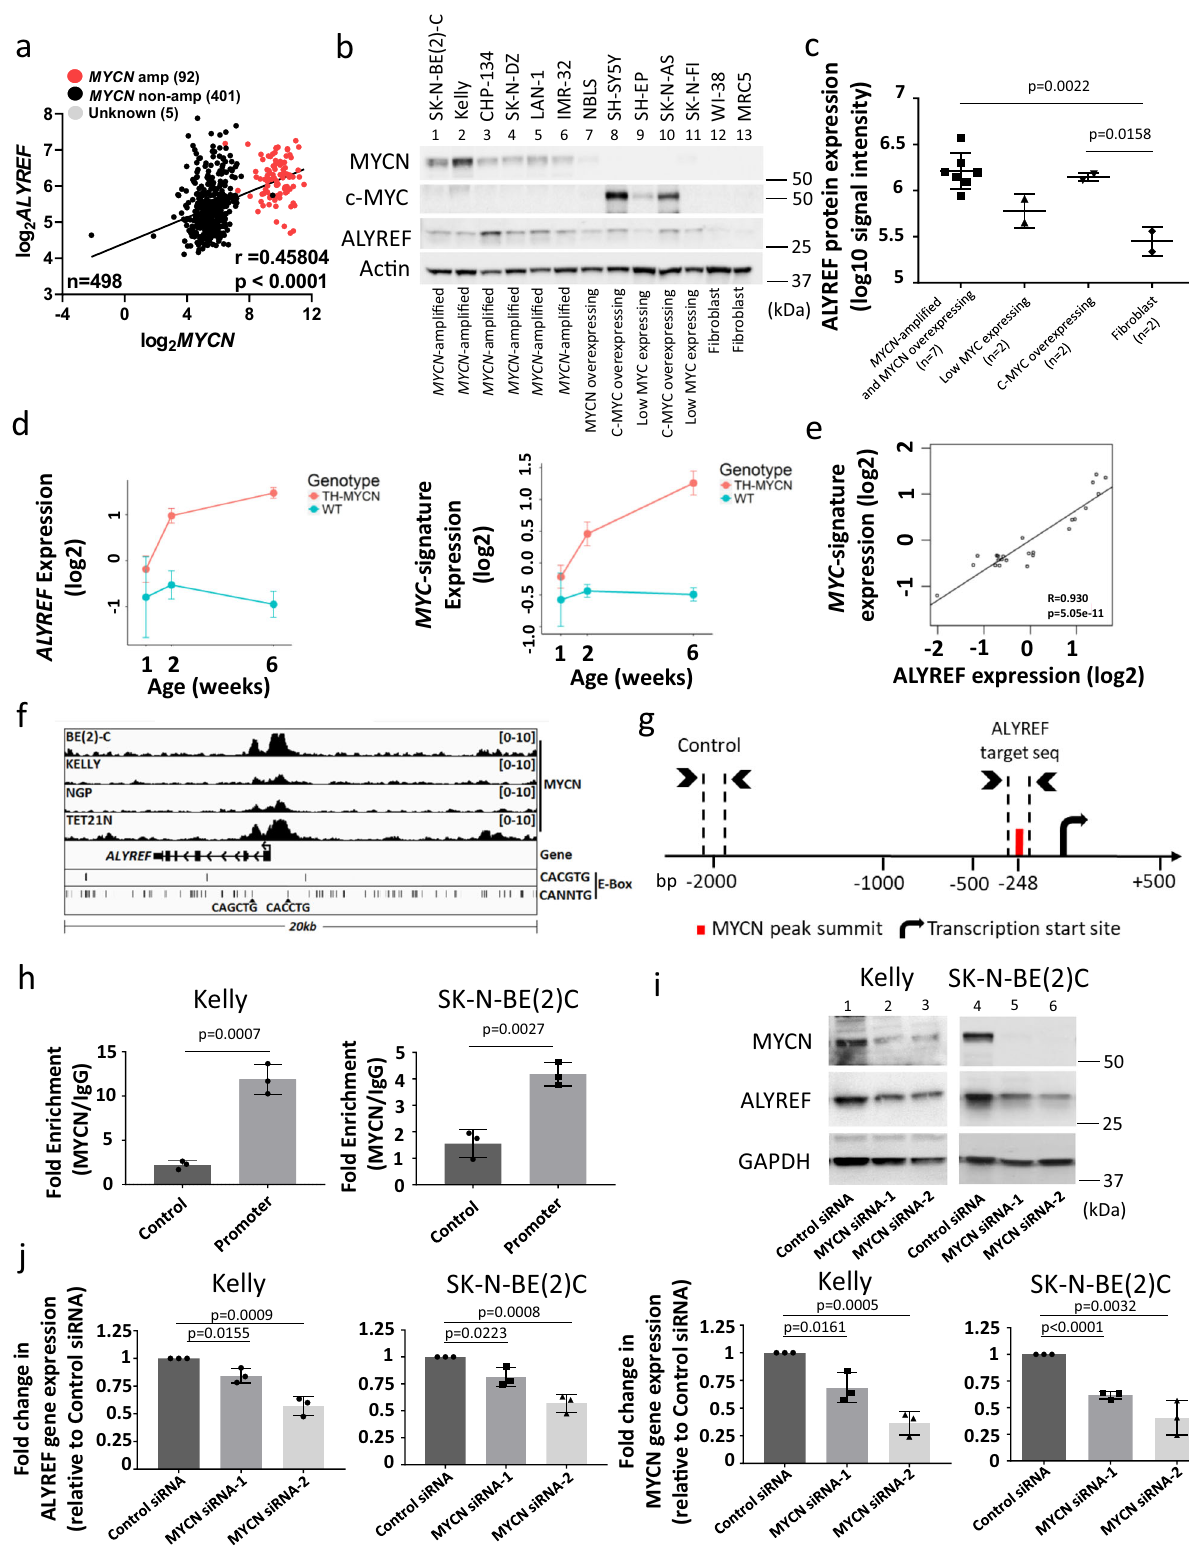
Fig. 2e, f) with MYCN siRNA-1 or MYCN siRNA-2 (lanes 2 – 3 and lanes 5 – 6) ef fi ciently knocked down MYCN protein (Fig. 2i and Supplementary Fig. 2e) and mRNA (Fig. 2j and